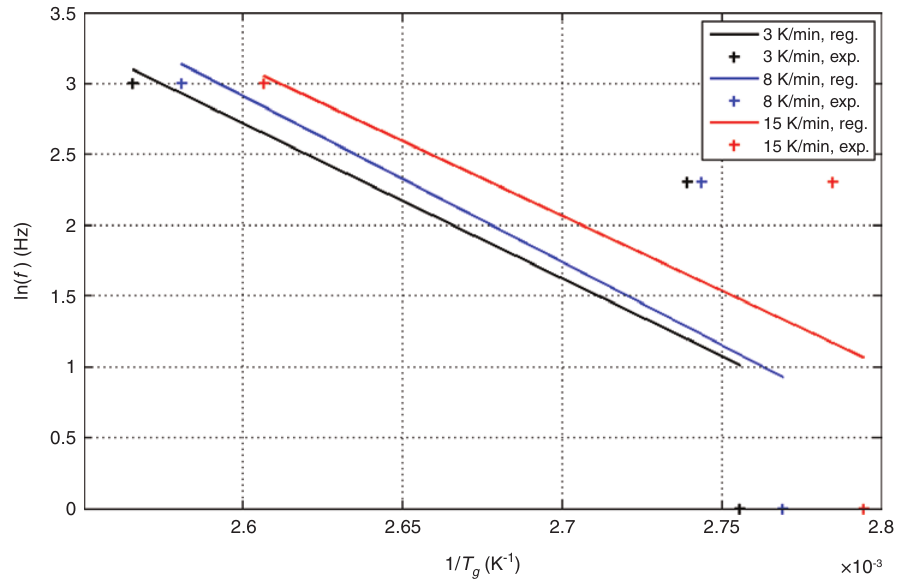
Figure 4: Arrhenius plot for pure epoxy.